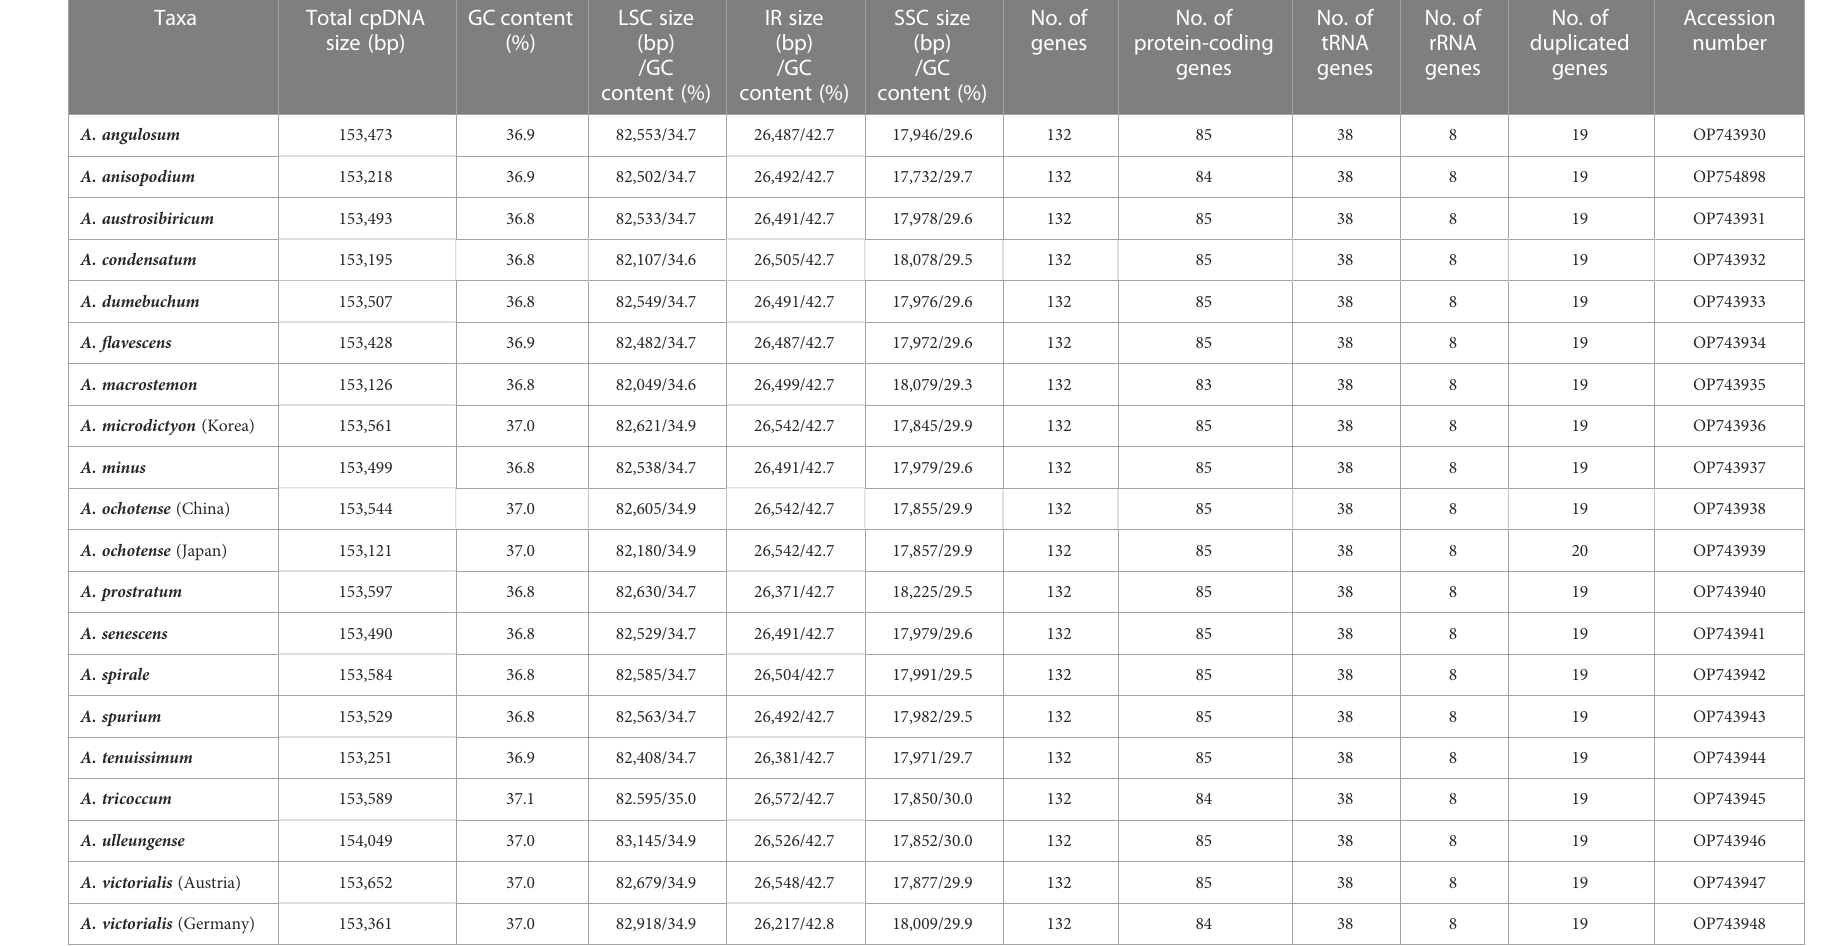
TABLE 1 Summary of the characteristics of the 20 Allium chloroplast